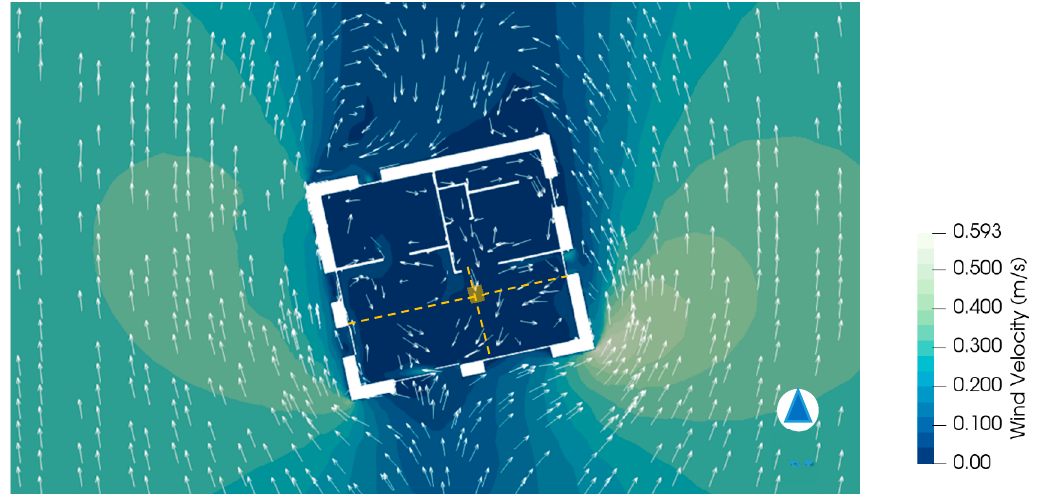
Figure 9. Velocity contours and vectors (x,y plane; h = 1.2 m) for south wind direction ( θ = 180°), 0.73 m/s (dashed line: measuring line along which the indoor air velocities were plotted; rectangle: anemometer’s region).